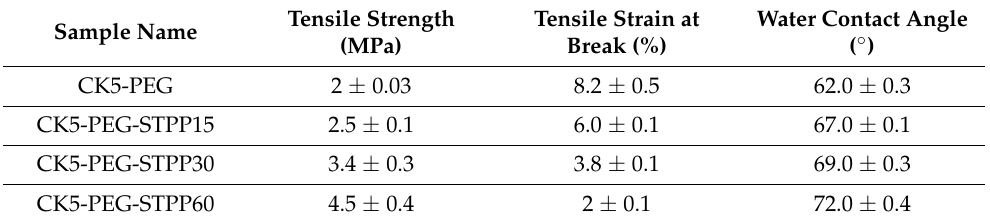
Table 2. Mechanical properties and water contact angle of the obtained composite